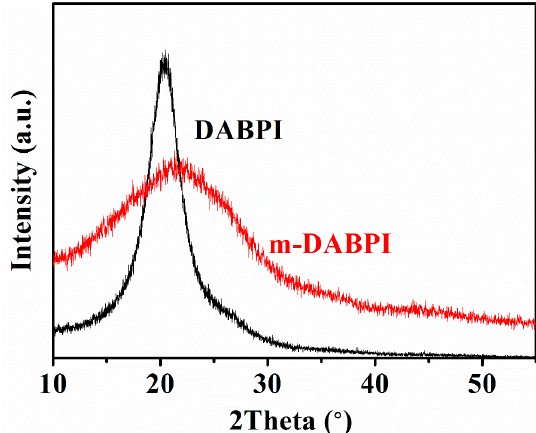
Figure 3. WAXD curve of DABPI and m-DABPI films. Table 3. Physical properties of DABPI and m-DABPI.